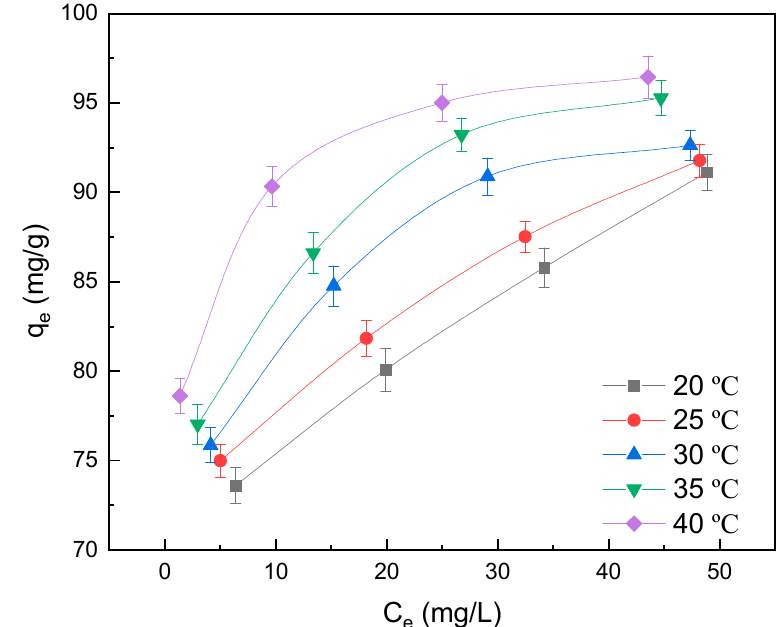
Figure 7. Relationship of equilibrium concentrations and equilibrium adsorption at different temperatures.